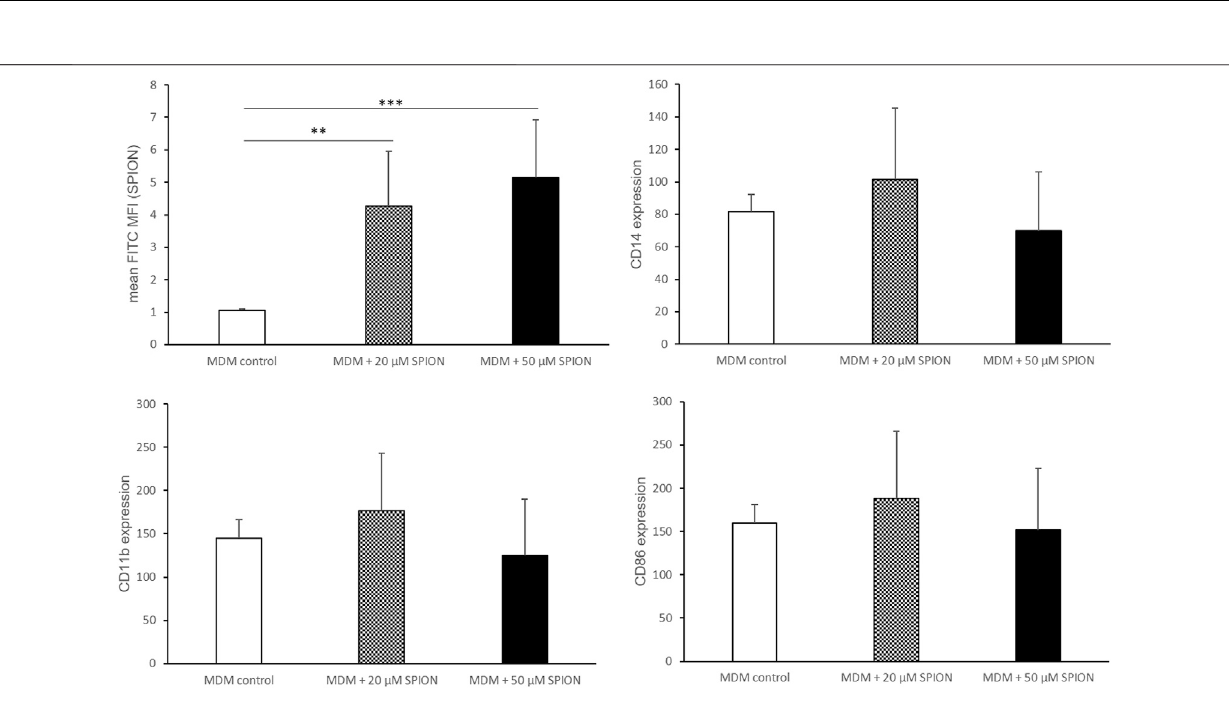
FIGURE 4 | Phenotype of SPION incubated monocyte-derived macrophages (MDMs). PMA-stimulated MDMs were incubated with or without SPIONs for 24 h. FITC expression of cells represents SPION uptake. Shown are the mean fl uorescence intensities (MFI) of each measured protein on the cell surface. Signi fi cance: student`s t -Test. ** p ≤ 0.01; *** p ≤ 0.001. n =